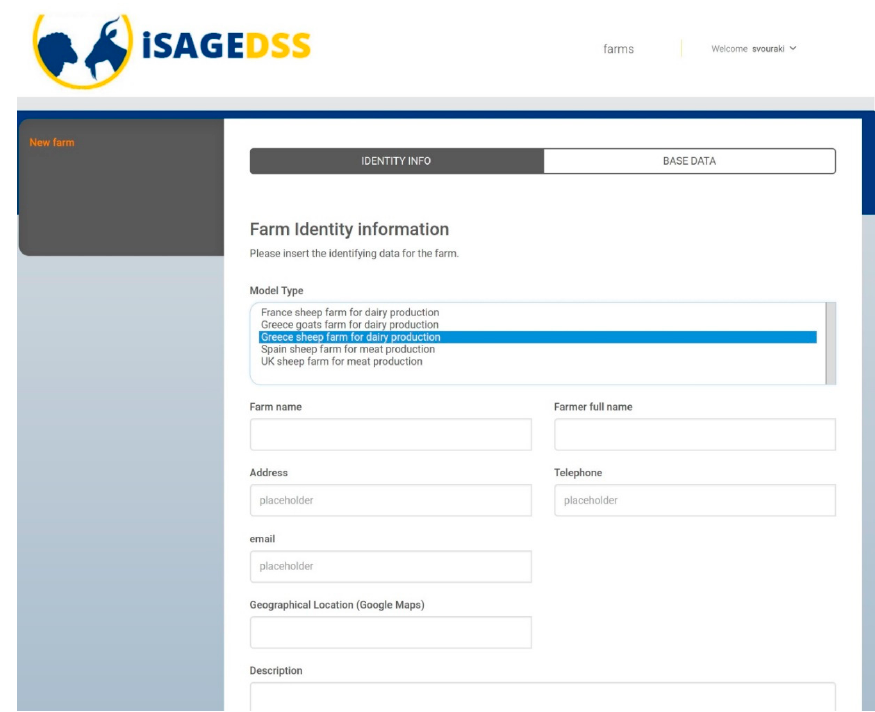
Figure 2. Creation of farm—farm identity information; users choose between five available model types based on production system and country. Animals 2020 , 10 , x FOR PEER REVIEW